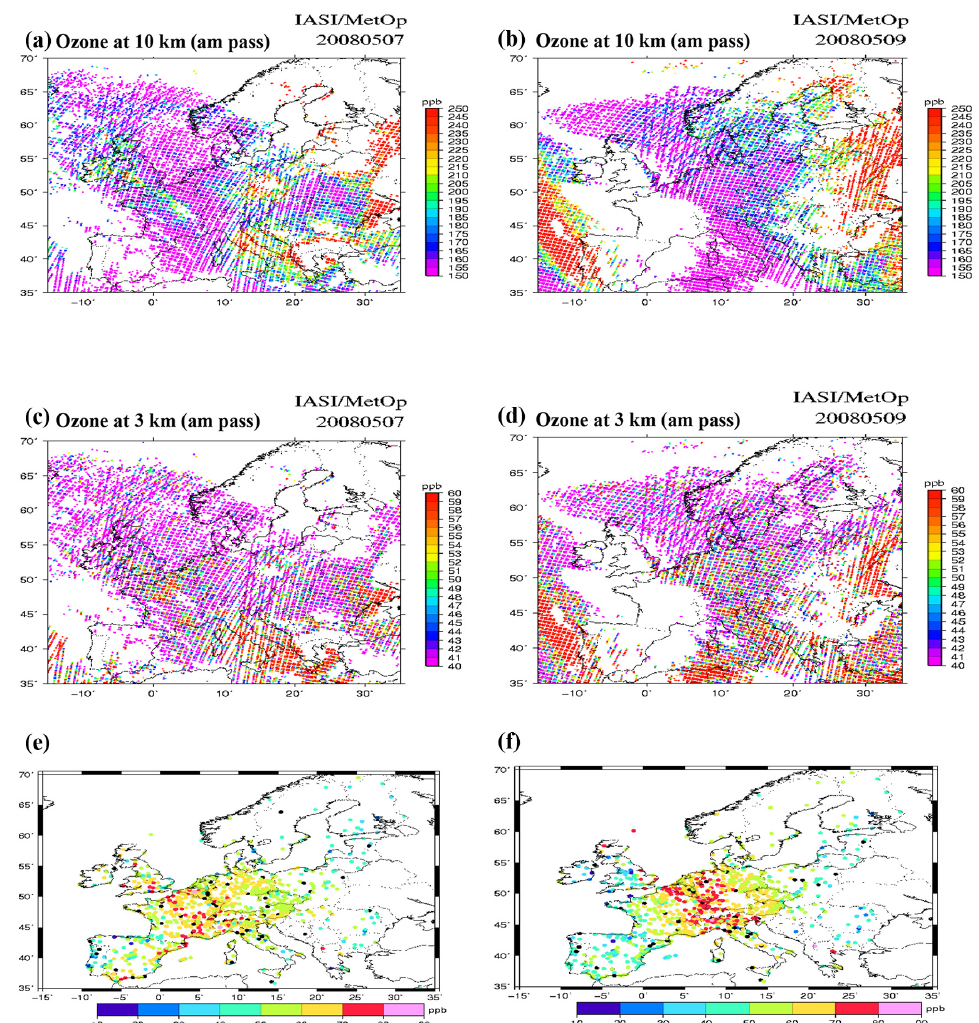
Figure 9. Daily IASI satellite ozone measurements at 10km level ( a, b ; in ppb) and at 3km level ( c, d ; in ppb) for 7 May 2008 (left column) and 9 May 2008 (right column). Values outside the scale range are set up to the upper and lower color code. (e, f) Hourly average surface ozone (EEA-AirBase) mixing ratios (ppb) at 15:00 for 7 May 2008 (left column) and 9 May 2008 (right column). Ozone data are from the EEA-AirBase